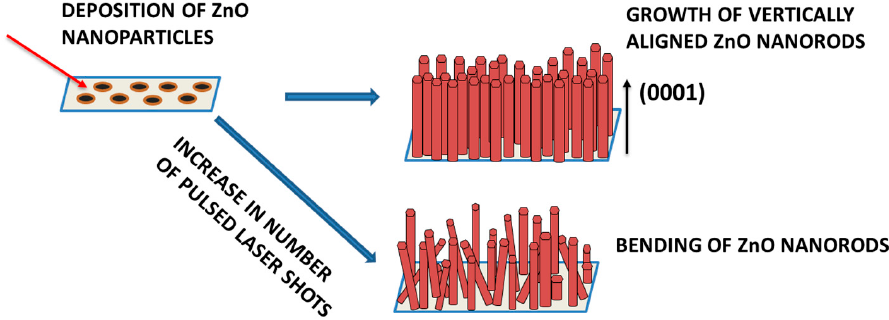
Figure 8. Schematic diagram of growth of vertically aligned ZnO nanorods (VAZO) by using high pressure assisted pulse laser deposition (PLD) process.